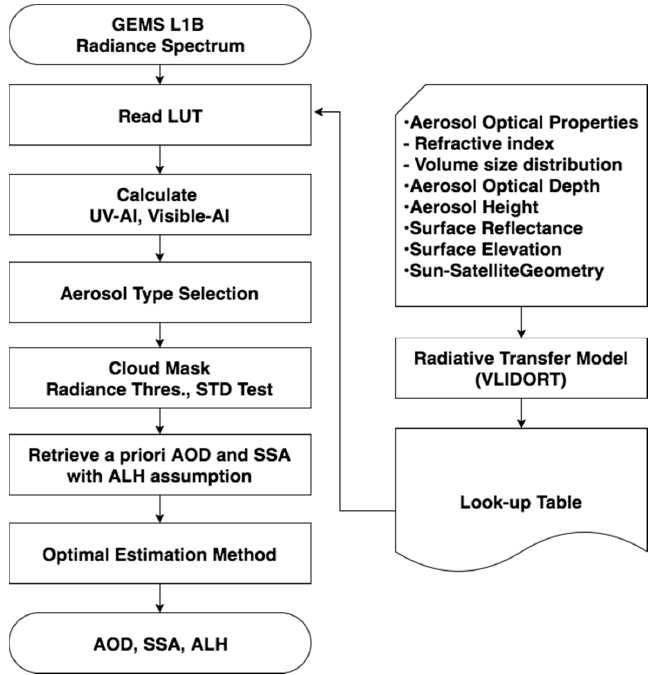
Figure 3. Flowchart of the UV-visible algorithm used to retrieve AOD, SSA and ALH.